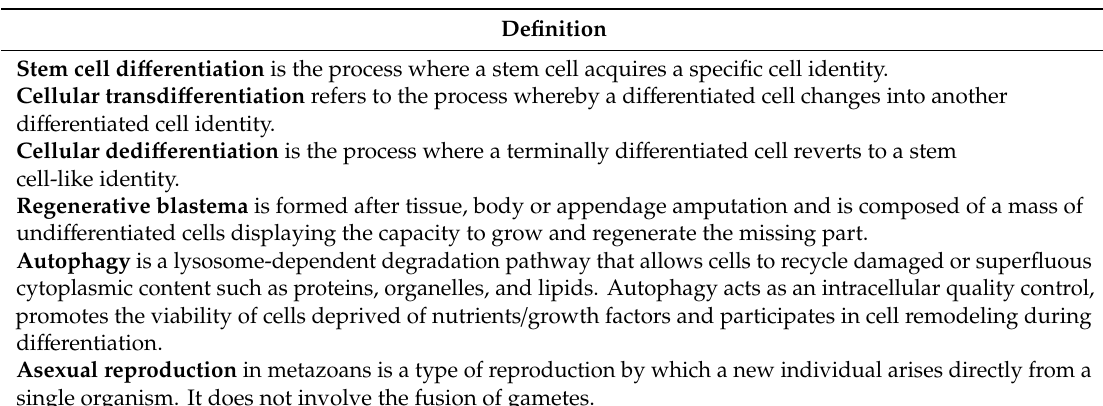
Table 1. Glossary of key terms used in this